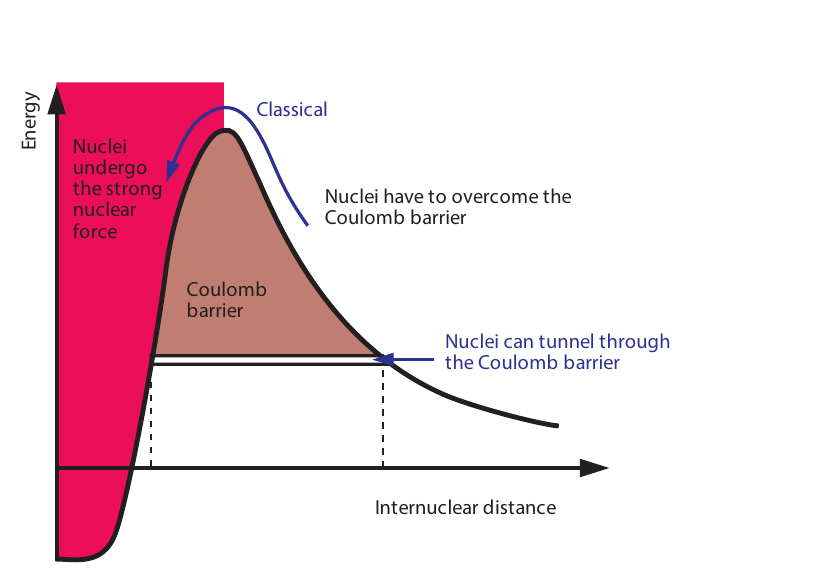
Fig. 2. – Atomic particles can overcome the Coulomb barrier (electrostatic repulsion) at much lower energies than the maximum by “tunnelling” through it. This increases the probability for